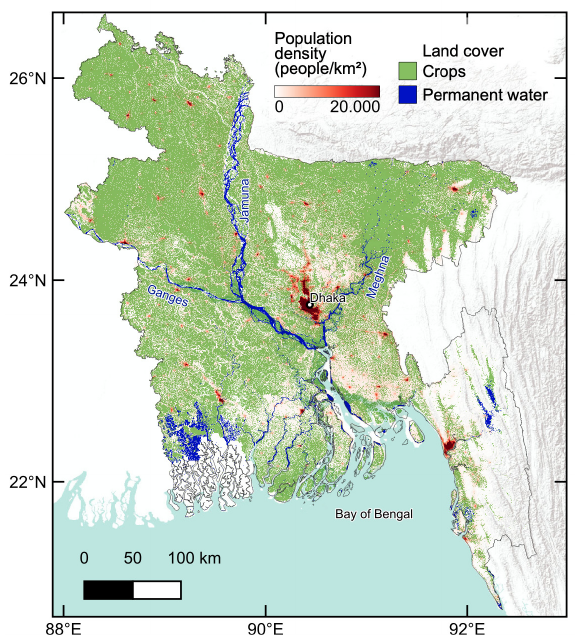
Figure 1. Land cover (crops and permanent water) and population density of Bangladesh overlaid on a shaded relief map. Three major rivers in Bangladesh are labeled. Population data from Tatem (2017), land cover data from Buchhorn et al. (2020), and shaded-relief map from Esri